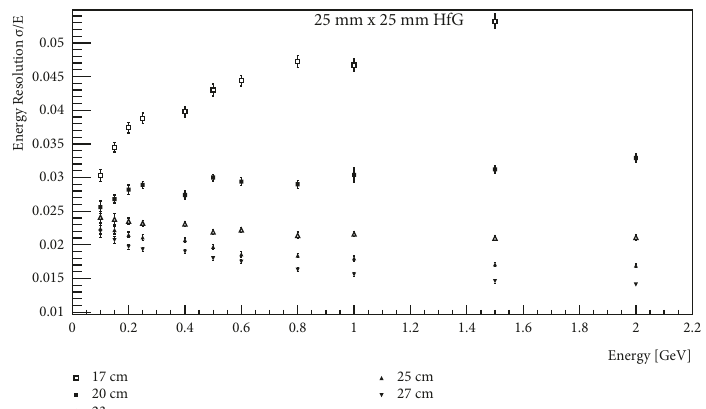
Figure 5: Energy resolutions as a function of beam energy for HfG with 25 mm x 25 mm back face area and five different thicknesses.